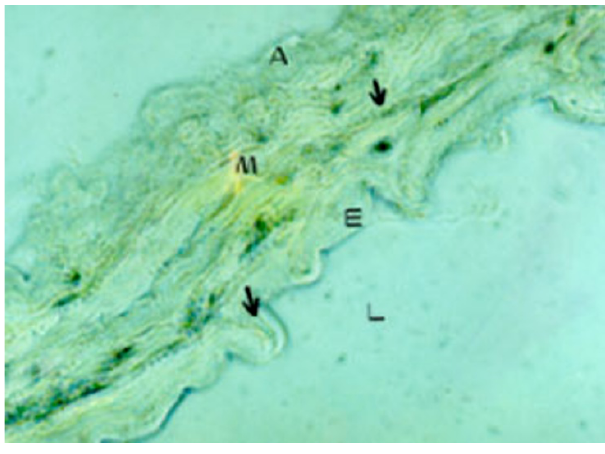
Figure 4 Aorta of an animal on a high cholesterol diet plus C. domestica (400 × ). Arrows indicate very little cholesterol deposits in the endothelium layer and media tunica